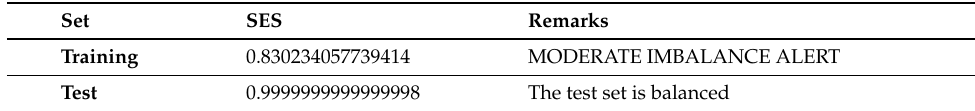
Table 3. SES results for the human reticulocyte dataset.